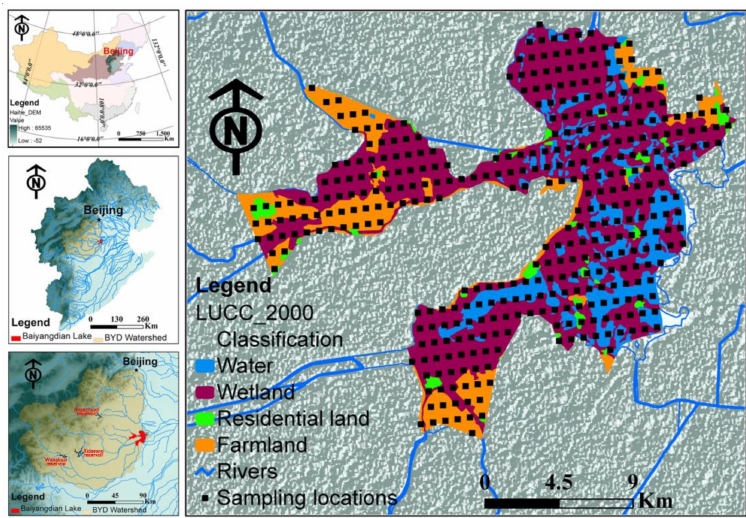
Figure 1. Geographical location of study area and sampling